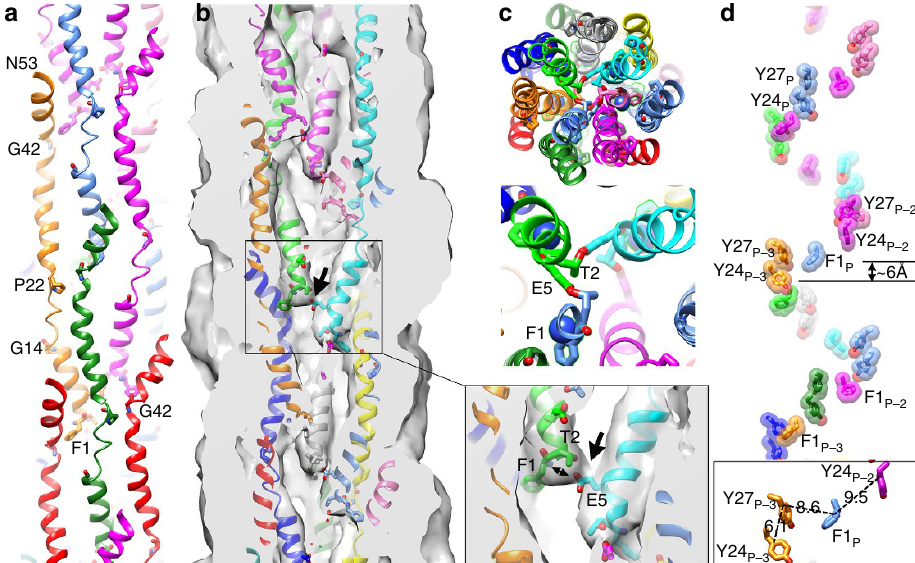
Figure 5 | Conformation and interactions among the N-terminal a -helices of the Nm T4P. ( a ) Side view of the a 1 segments only (residues 1–53) from the outside of the pilus, with Phe1, Glu5, Gly14, Pro22 and Gly42 shown in stick representation. ( b ) Cross-section of the a 1s in the cryoEM map. The interaction between the Glu5 side chain on one subunit and Phe1:N and the Thr2 side chain in the adjacent subunit in the 1-start helix is shown enlarged. The arrow points to the electron density corresponding to these contacts. The Phe1 side chain interacts with a 1C in the globular domain of an adjacent subunit. ( c ) End view of the a 1 core with a close-up of the interactions between Glu5 and Thr2 and Phe1:N (shown as a blue sphere). ( d ) Positions of the aromatic side chains of conserved residues Phe1, Tyr24 and Tyr27, all on a 1. Residues are numbered according to the position of their corresponding subunit or protomer, Pn, relative to the central subunit P (light blue). The Phe1 side chain is located between Tyr24/27 pairs on adjacent a 1s in the þ 1 helix, resulting in a continuous band of aromatic side chains that winds up the filament axis. These residues are implicated in electron transfer for the conductive G. sulfurreducens T4P 48,49 . C g –C g distances for the final Nm T4P model are shown in the inset, although their precise positions are not known with certainty due to the limited resolution of the